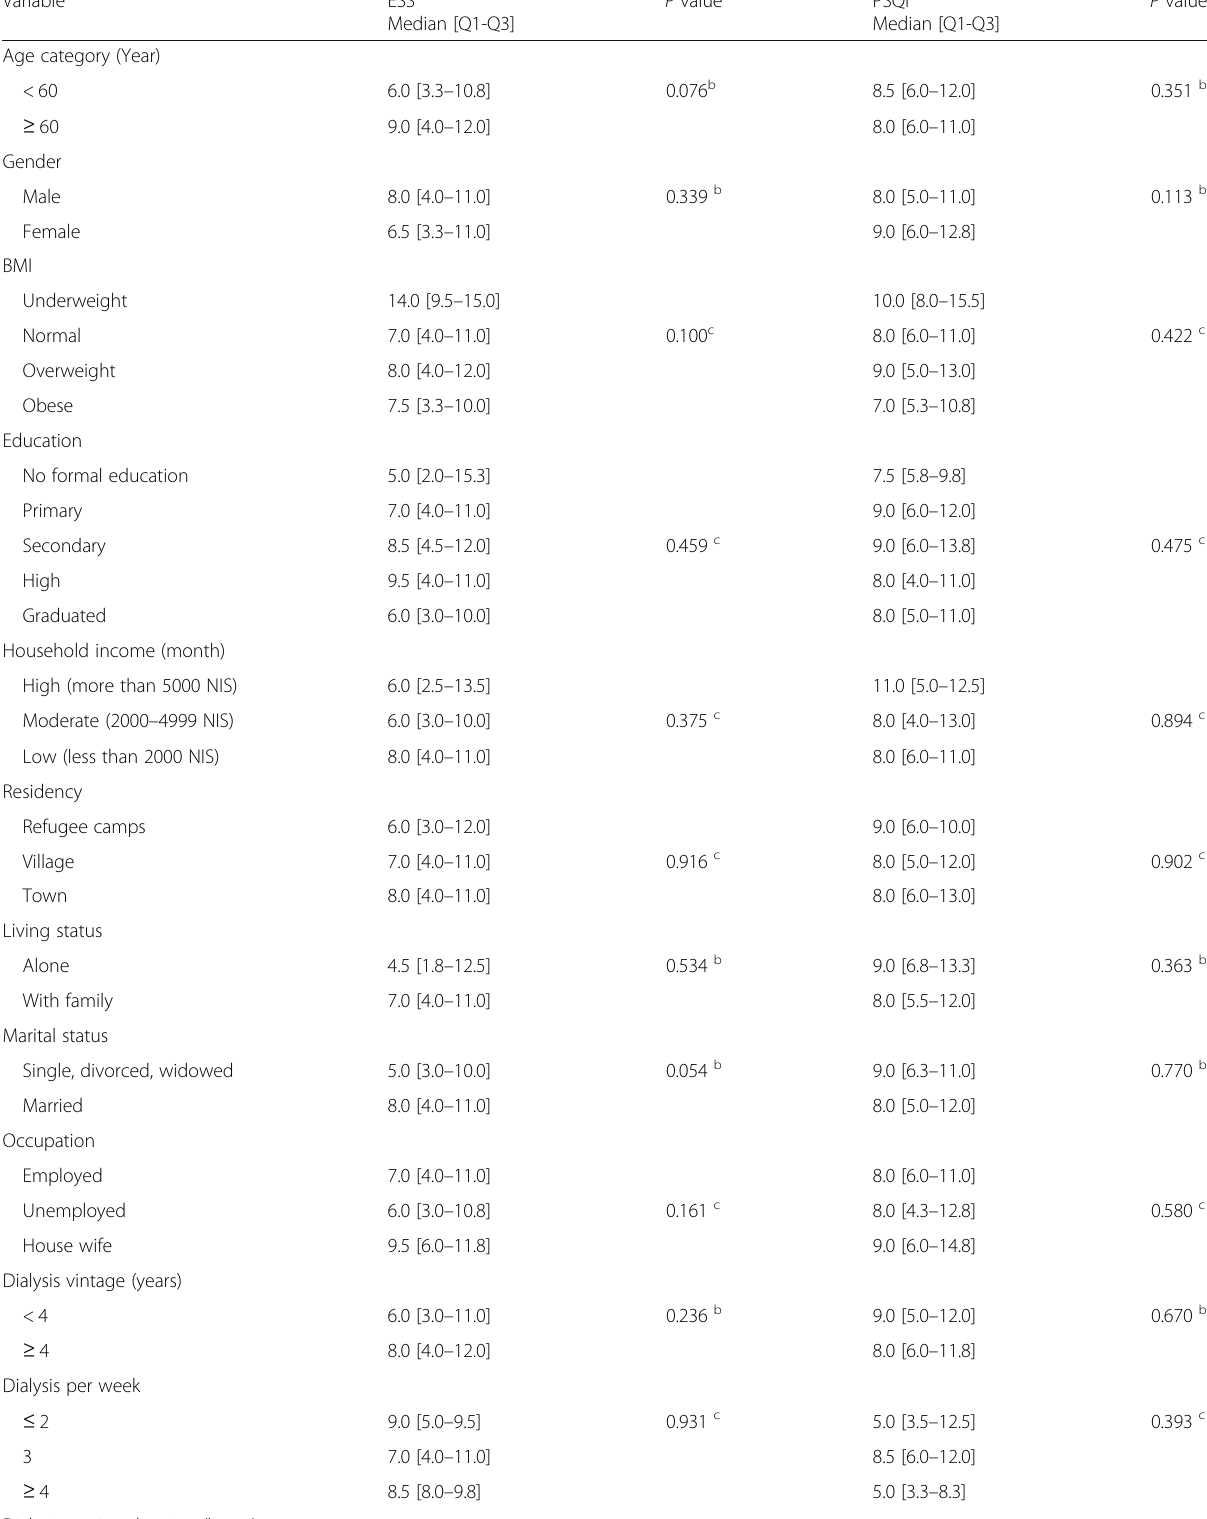
Table 2 Relationship between characteristics of participants and their Epworth sleepiness scale and PSQI